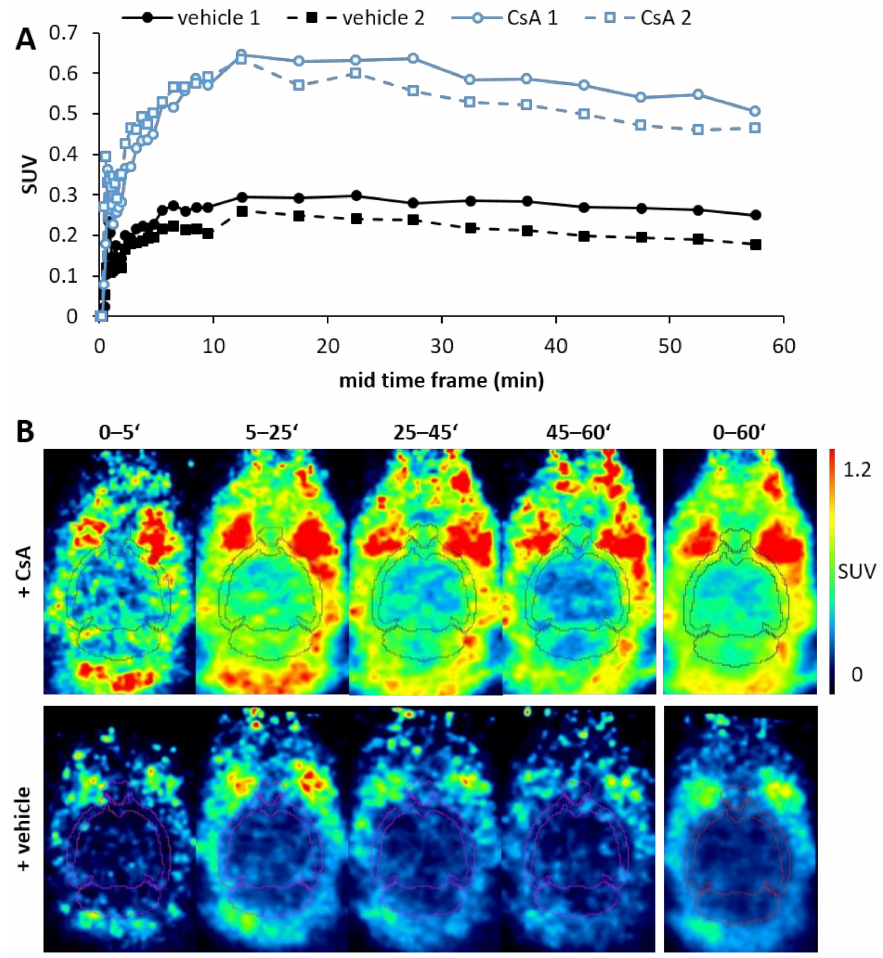
Figure 3. ( A ) Time–activity curves (TACs) of CD-1 mice brain region after pre-administration of vehicle ( n = 2; black line) or cyclosporine A (CsA; P-gp inhibitor, 50 mg/kg, n = 2; blue line) 30 min pre- injection of [ 18 F] BA3 . ( B ) Horizontal representative PET image of the brain after pre-administration of vehicle or